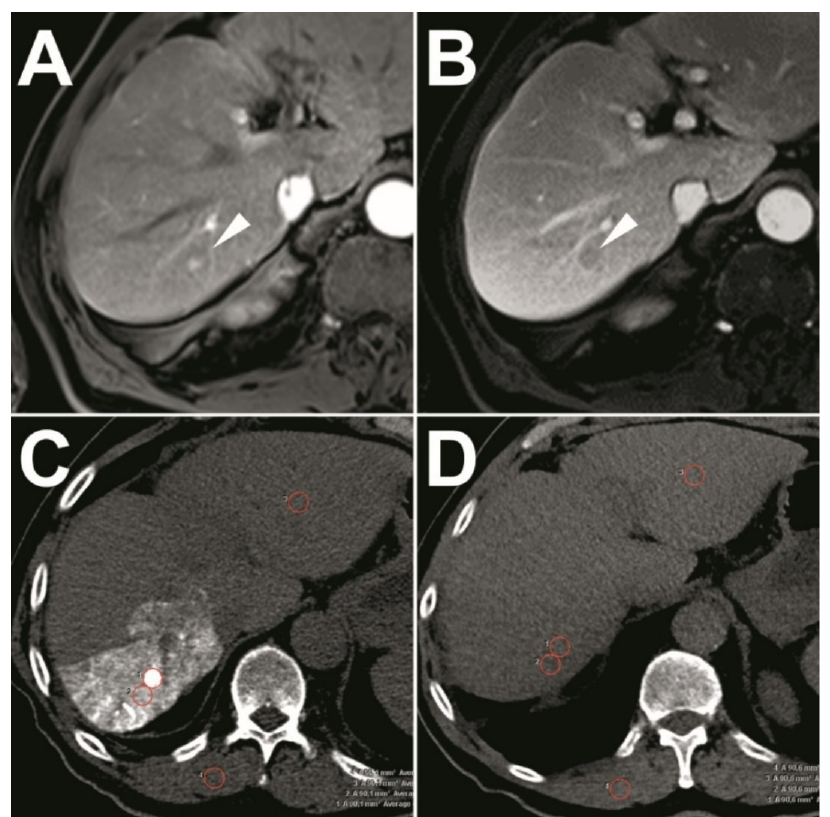
Figure 2. An exemplary illustration of the quantitative Hounsfield scale measurements. A target- HCC with typical arterial APHE ( A ) and “washout” in the portal phase ( B ). Branches of portal veins surrounding the lesions were observed ( B ) so the IRE was chosen in avoidance of “heatsink” if thermal ablation was performed. In the post-marking CT images, the target-HCC (arrowhead) was opacified, which was defined as complete visualization ( C ). In the Hounsfield scale measurements, the circular or oval region-of-interests (ROIs) (red circles) manually covered the entire target-HCCs ( 1 ), the surrounding normal liver tissue ( 2 -the region adjacent to the target-HCC with visually highest density), the distant normal liver parenchyma ( 3 ), and paravertebral muscles ( 4 ) with the same size and shape. Large vessels and prominent artifacts were avoided carefully. The identical measurements with the same rules were performed on the pre-marking CT images ( D ). However, because